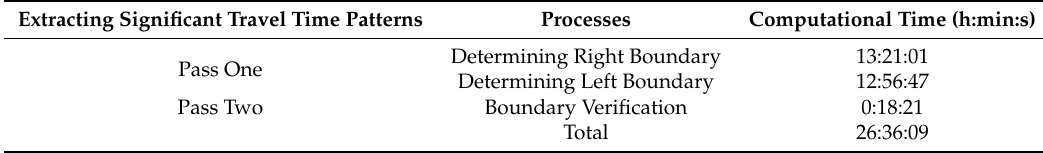
Table 6. Computational time via a Hadoop cluster with two name nodes and six computing nodes. Extracting Significant Travel Time